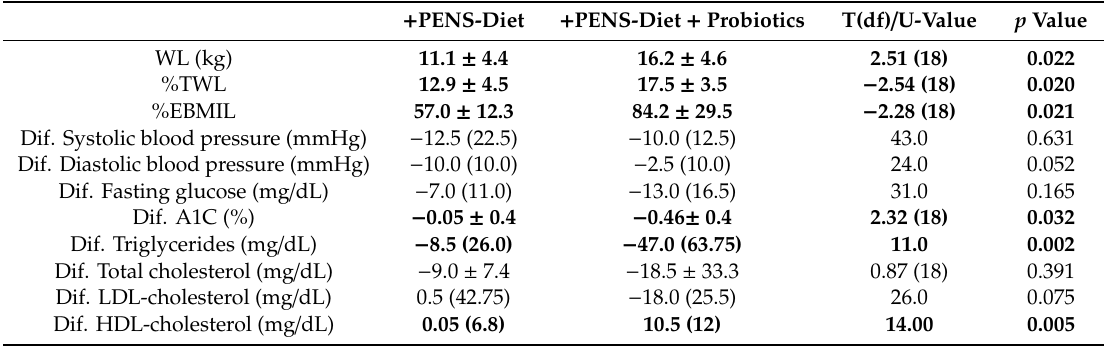
Table 4. Di ff erences in weight loss, blood pressure, and plasma parameters between PENS-Diet and PENS-Diet +